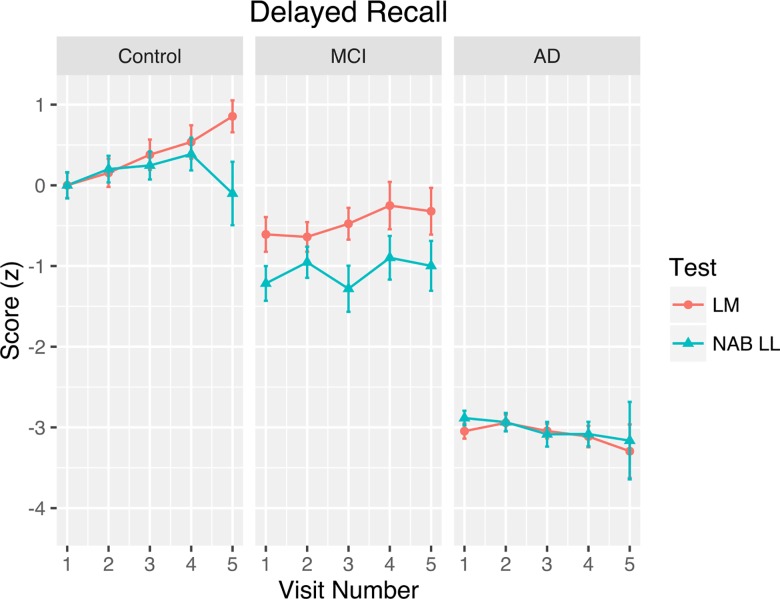
Delayed Recall Practice Effects.Standardized test scores on the delayed recall condition as a function of visit number, test, and clinical diagnosis. Error bars represent 95% confidence intervals and account for within-subjects variability.